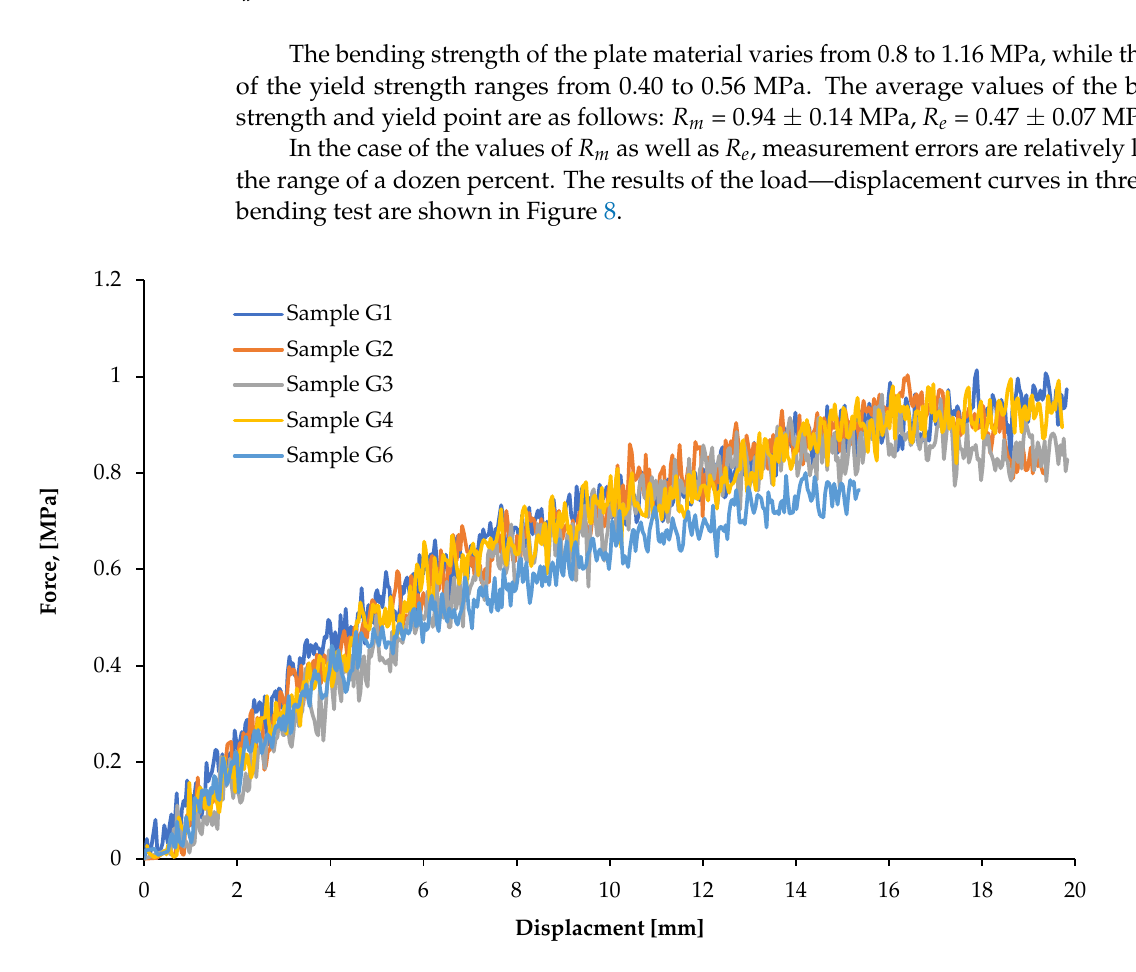
Figure 8. Load—displacement curves in three-point bending test (samples G1—G6).